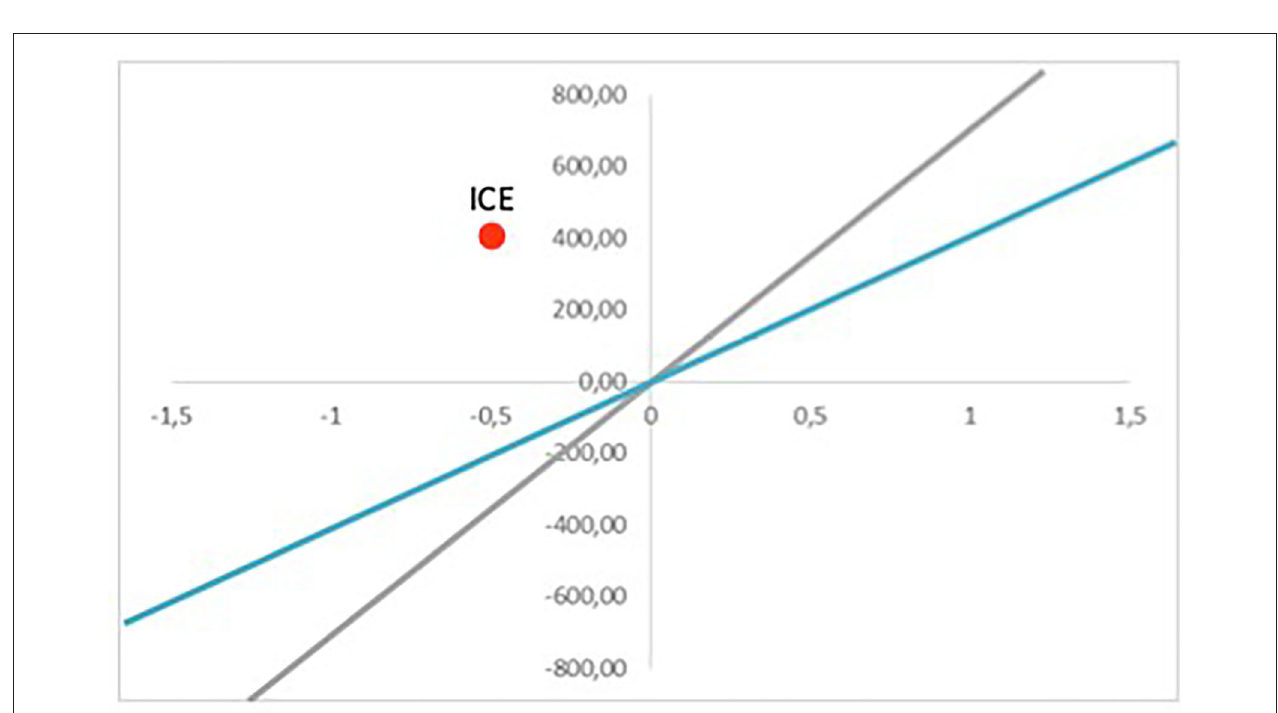
FIGURE 9 | Cost-effectiveness plan (Scenario